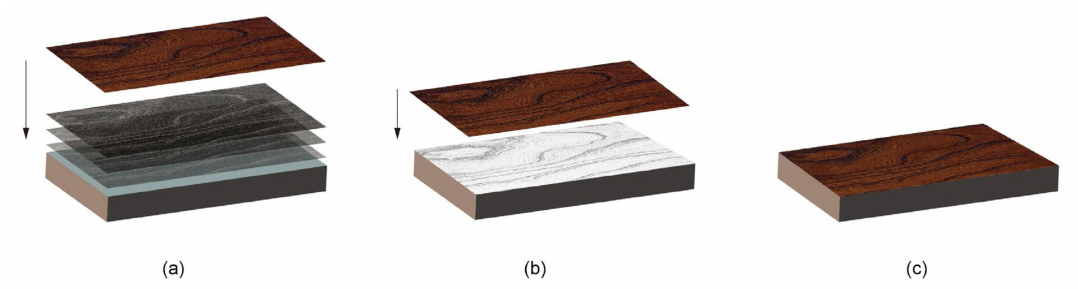
Figure 7. ( a ) Printing images pixel-to-pixel aligned ( b ) texture mapping on the white 3D grain mode ( c ) a wood-based board with a 3D wood texture surface.